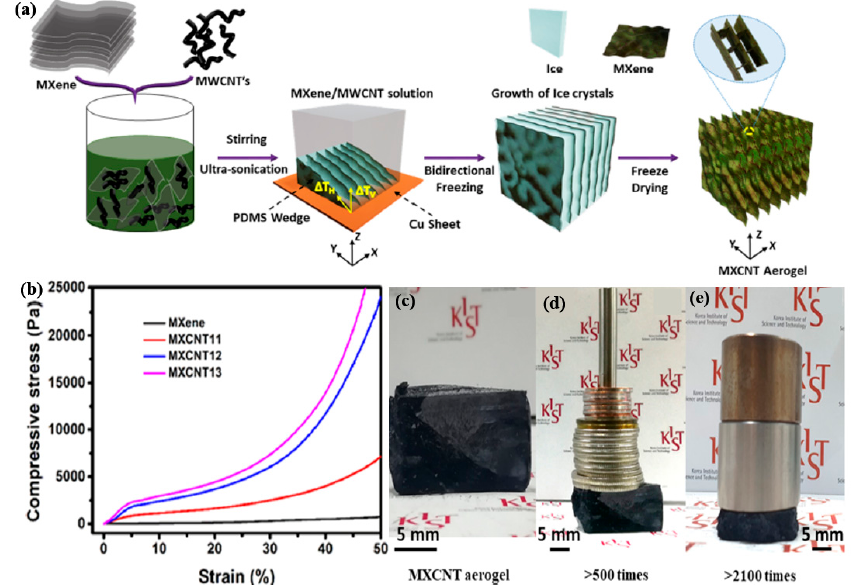
Figure 11. ( a ) Preparation of MXene/CNT hybrid aerogels through bidirectional freezing approach ( b ) Stress-strain curves of pristine MXene aerogels and MXene/CNT hybrid aerogels samples ( c – e ) MXene/CNT hybrid aerogels supporting more than >500 and >2100 times of its weight with no obvious collapsing. Adapted and reproduced with permission from [ 115 ] . Copyright ACS, 2019.